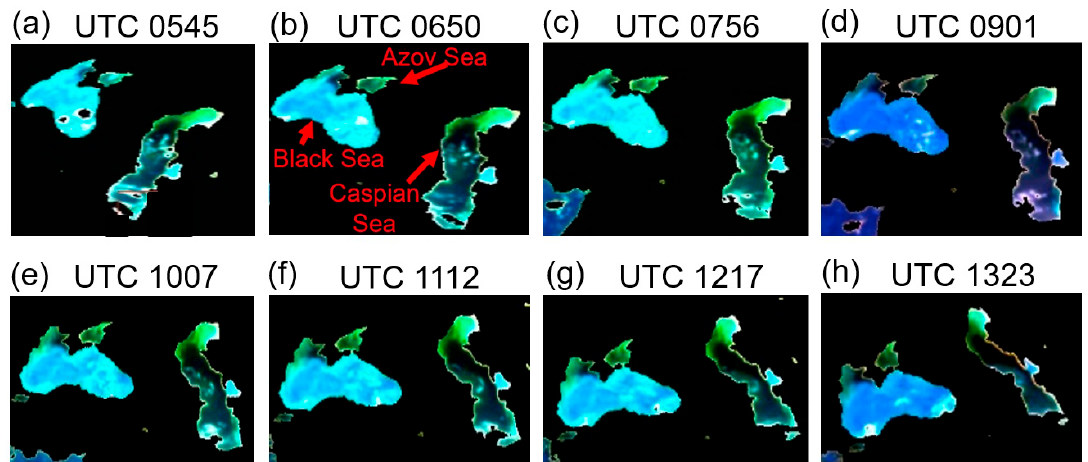
Figure 6. ( a )–( h ) Eight color images processed from atmosphere corrected EPIC channel (Red: 680 nm; Green: 551 nm; Blue: 443 nm) images acquired on 26 June 2017 at UTC 0545, 0650, 0756, 0901, 1007, 1112, 1217, and 1323, respectively, and covering areas consisting of Caspian Sea, Black Sea, and Azov Sea with land and cloud features masked out.